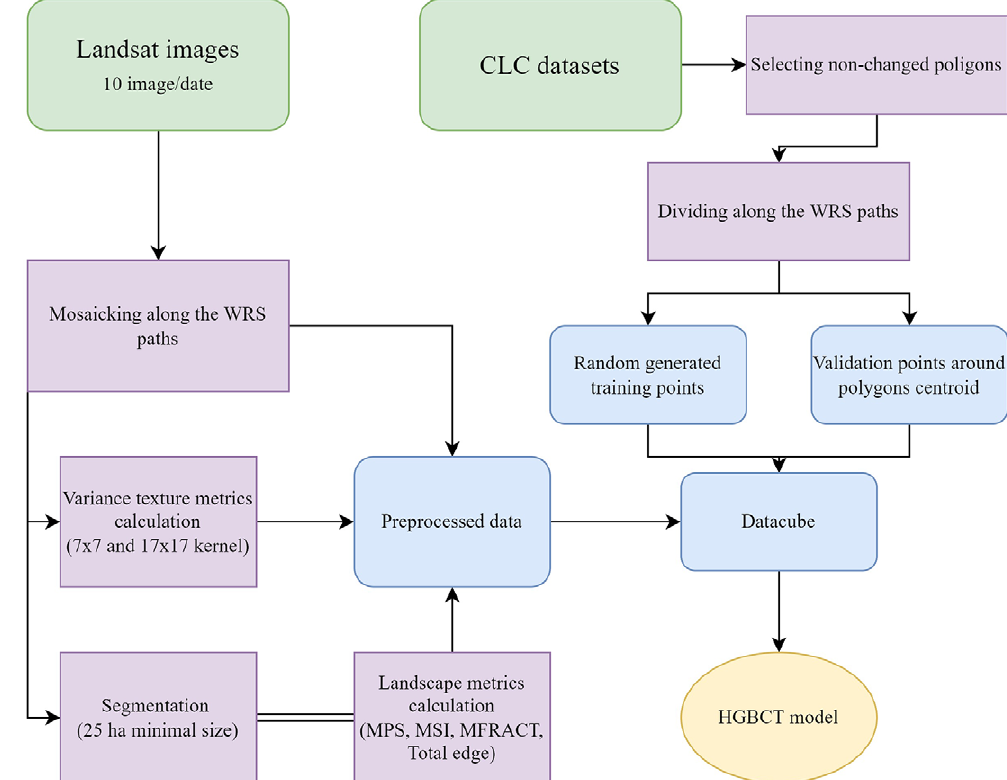
Figure 5. Data processing